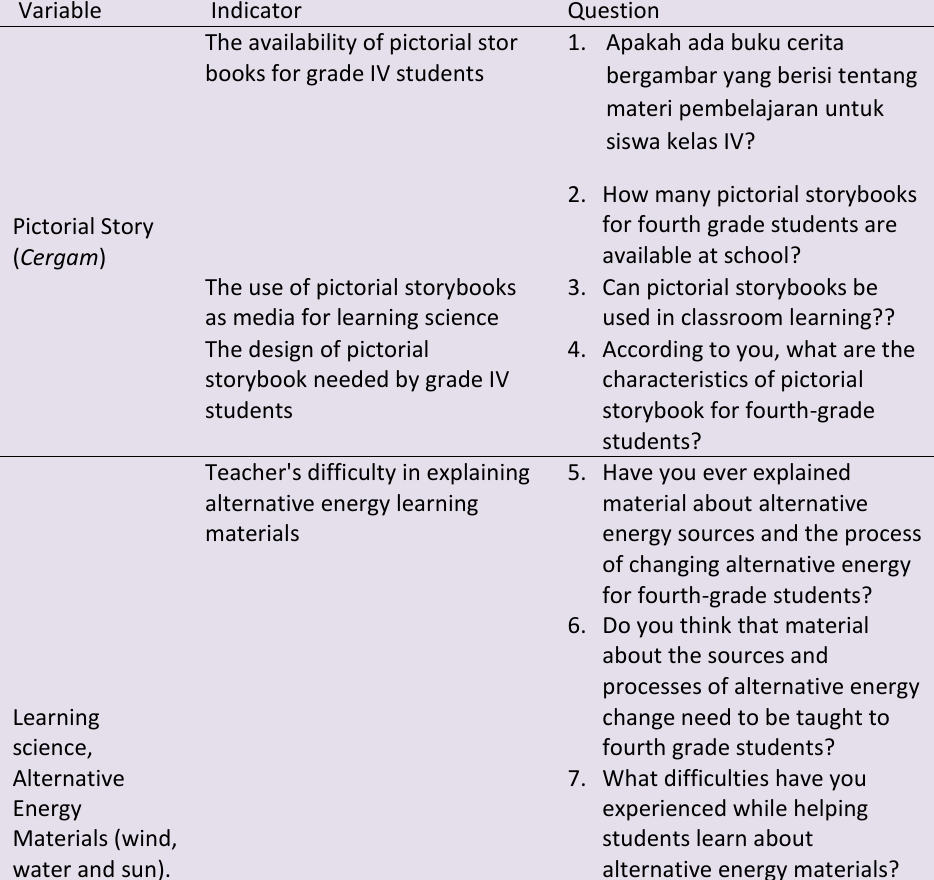
Table 2 . Interview Guideline for